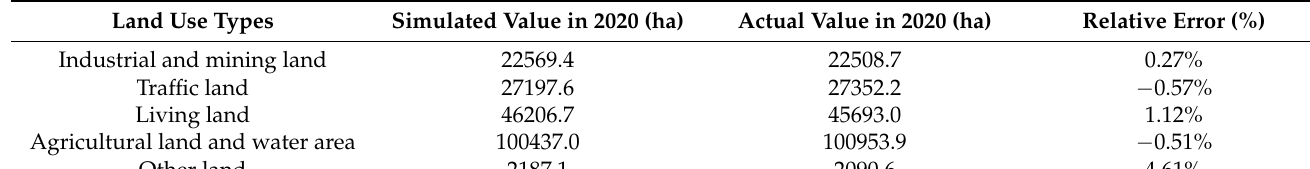
Table 3. The accuracy test of system dynamics (SD) model simulation results.